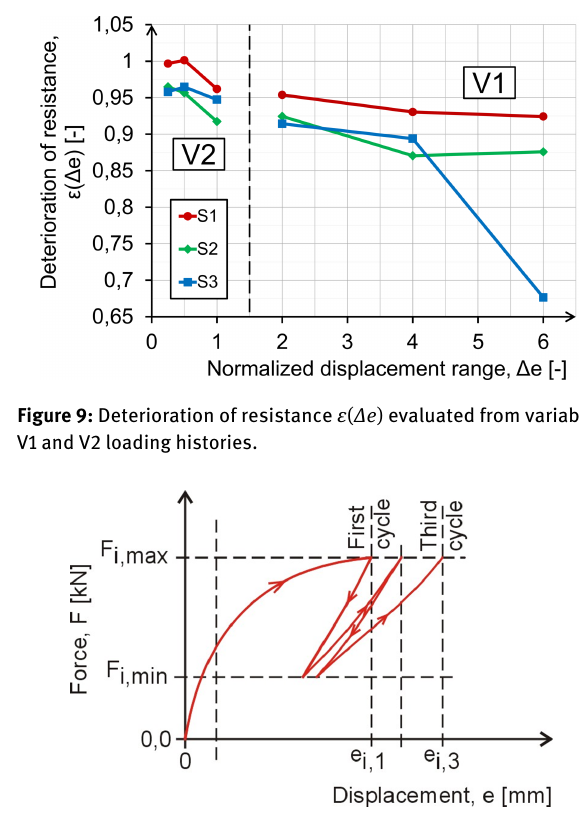
Figure 10: Method of prediction e i ,1 and e i ,3 values (maximum displacement in the first and third cycle at the same force range ∆F